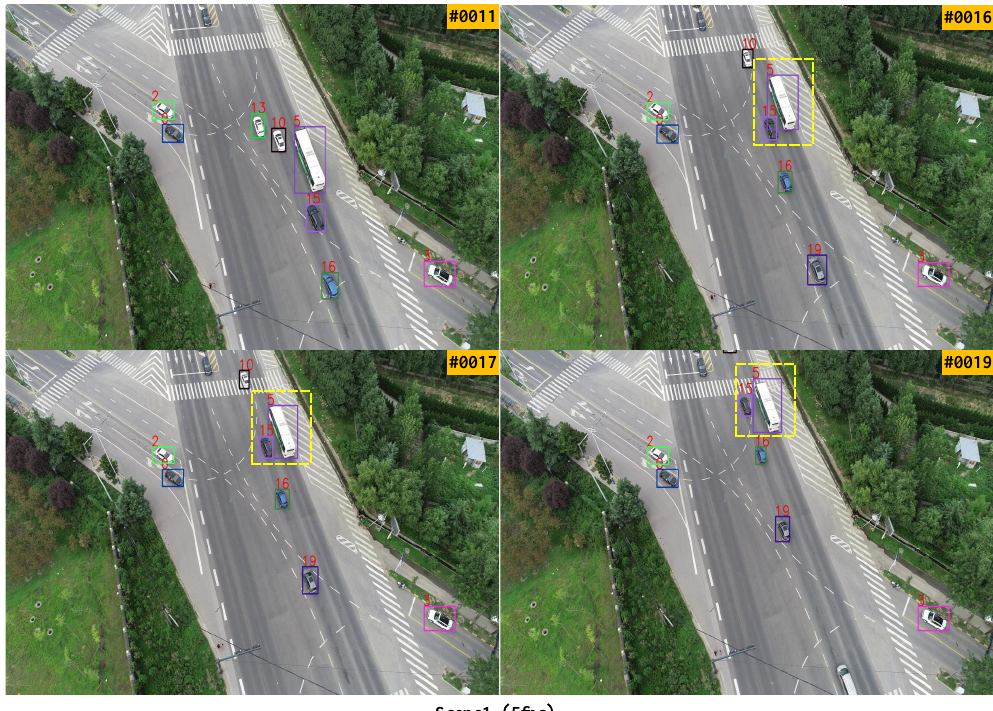
Figure 7. Tracking results of four tracking algorithms in Scene 1 with 5 fps frame rate, enlarged to show tracking effect more clearly. This set of results mainly shows that the algorithm could track crowded targets well when the frame rate of the intersection was only 5